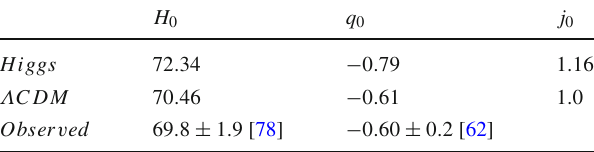
Fig. 11 Plots for the effective equation of state of Model I I I using different ranges of redshift. The best fit, 1 σ and 2 σ confidence regions, obtained in the combined analysis are shown Table 3 Comparison of the cosmographical